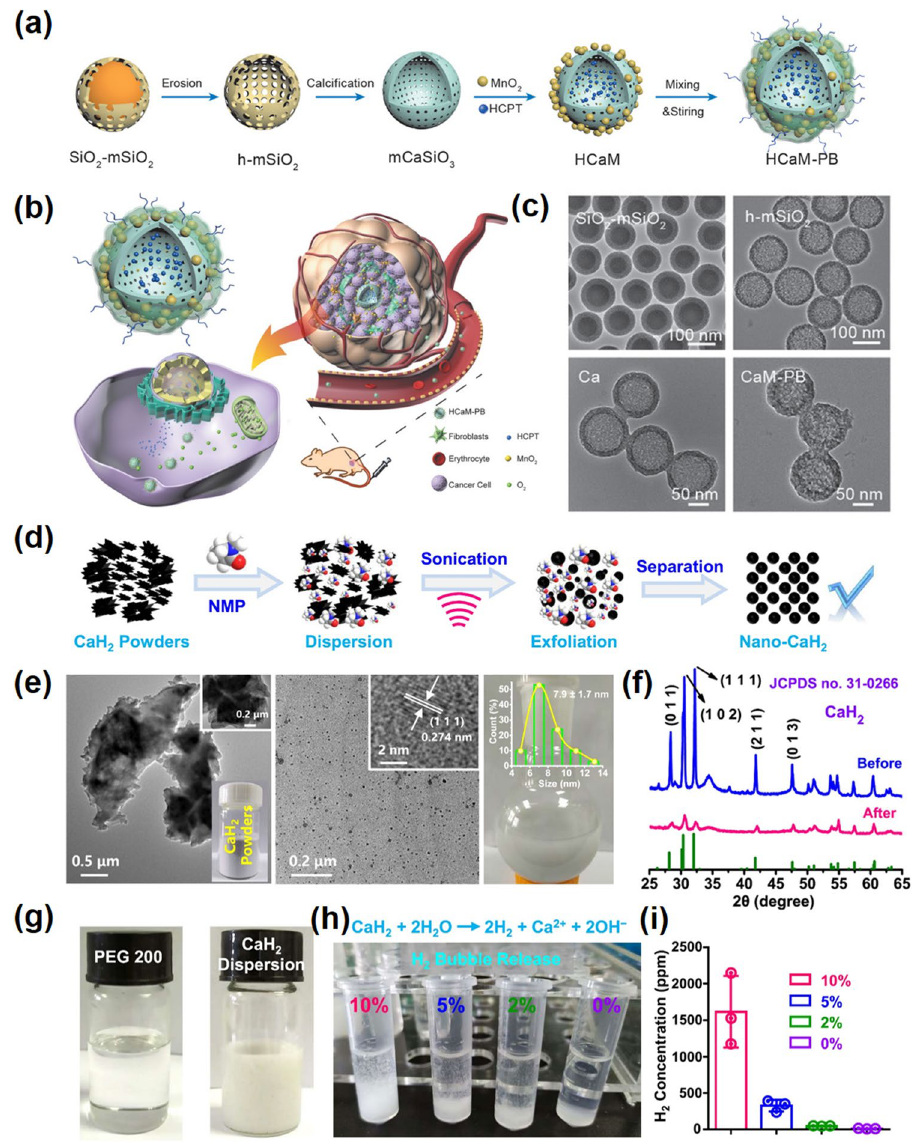
Fig. 7 Other forms of Ca-NMs. a Synthesis process of HCaM-PB. b Schematic diagram of HCaM-PB application in tumor therapy. c TEM images of SiO 2 @mSiO 2 NPs, h-mSiO 2 NPs, Ca NPs, and CaM-PB NPs [95]. Copyright 2019, Wiley–VCH. d Synthesis procedure of nano- CaH 2 . e TEM images of the CaH 2 powders (left panel) and the nano-CaH 2 (middle panel). A photograph of commercial CaH 2 powders is inserted in the left panel and a lattice structure of nano-CaH 2 is inserted in the middle panel. A photograph of nano-CaH 2 in N-methylpyrro- lidone (right panel). The inserted figure shows the hydration size of nano-CaH 2 . f XRD of nano-CaH 2 and CaH 2 powders. g A photograph of PEG-200 (left panel) and nano-CaH 2 dispersed in PEG-200 solvent (right panel). h The photograph of the H 2 produced in different proportions of H 2 O solution. i The generated H 2 concentration in different solutions determined by gas chromatography [92]. Copyright 2022,